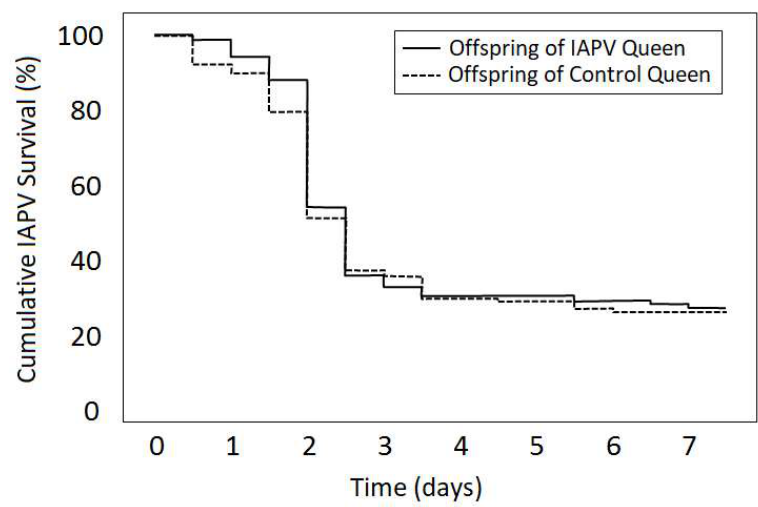
Figure 2. Survival of IAPV-inoculated offspring from IAPV-exposed and control queens. IAPV survival of workers produced by eight queens that were pre-exposed to IAPV was compared to workers from eight sham-treated control queens in laboratory cages. Despite significant variability among queens (data not shown), survival of offspring from inoculated queens was not significantly different from the survival of offspring from non-infected queens. the end of the experiment (Figure 3).